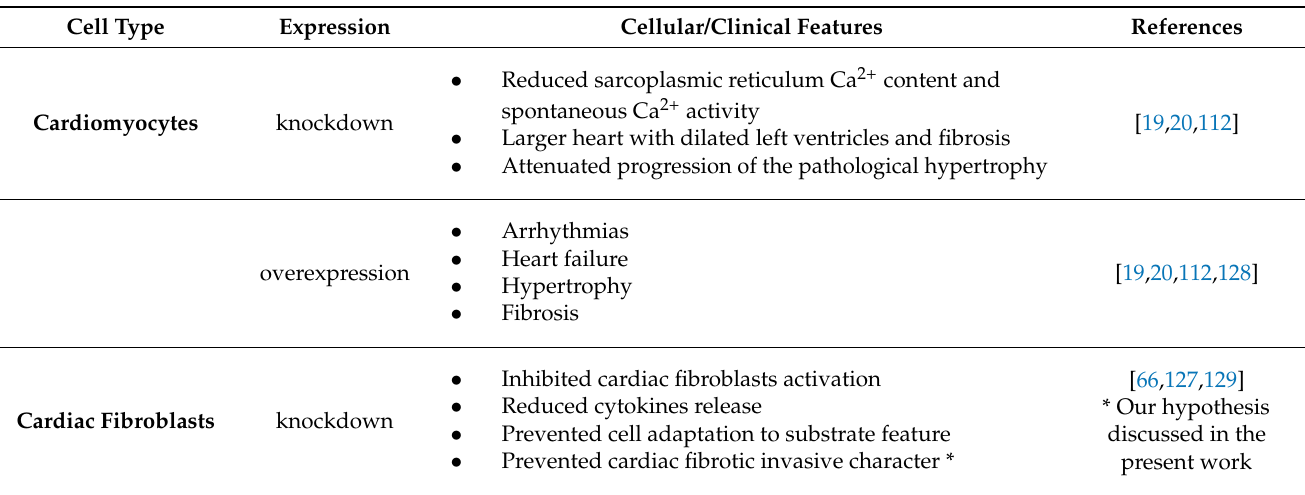
Table 1. Overview of Piezo1 dysfunctional regulation in cardiac cells (myocytes and fibroblasts) and related cellular/clinical features. * Refers to our hypothesis about Piezo1 beneficial targeting in fibroblasts discussed in the present